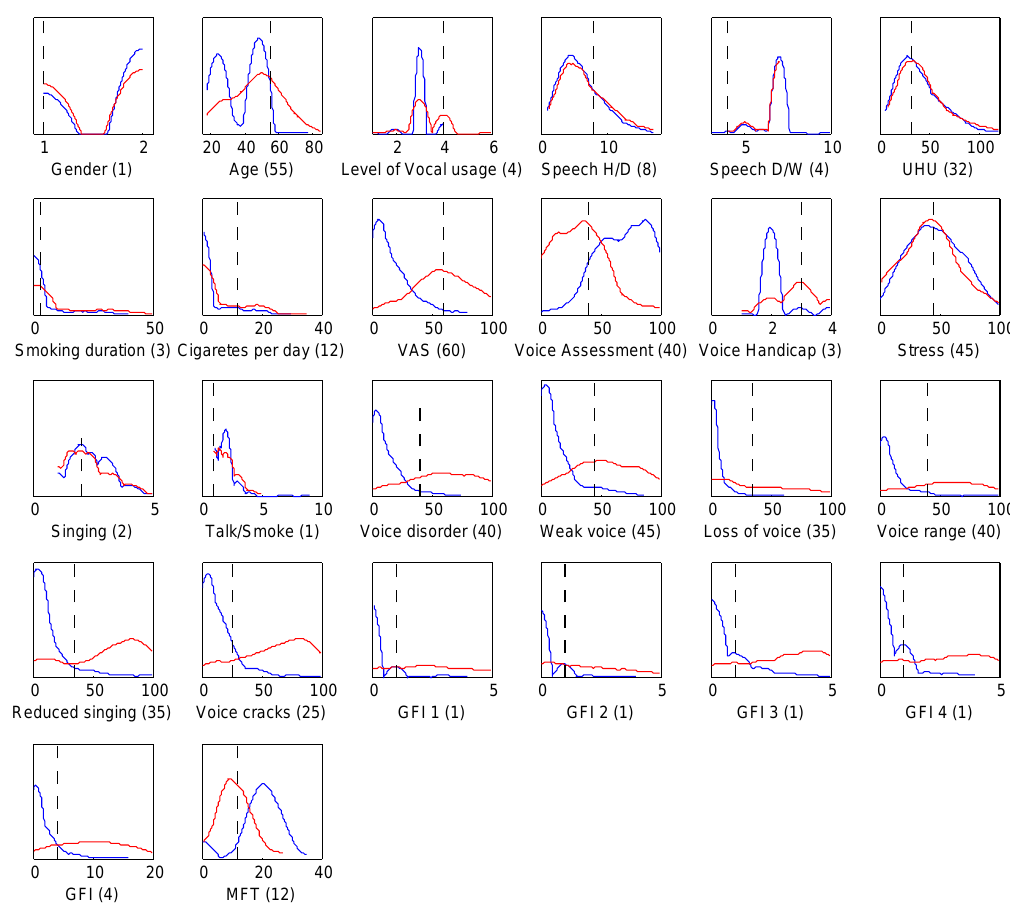
Figure 6. Probability ( y -axis) density functions of query parameters for healthy (blue) and pathological cases (red). A dashed line and numbers in the parentheses correspond to a parameter value of a subject randomly selected from the database used to train the developed